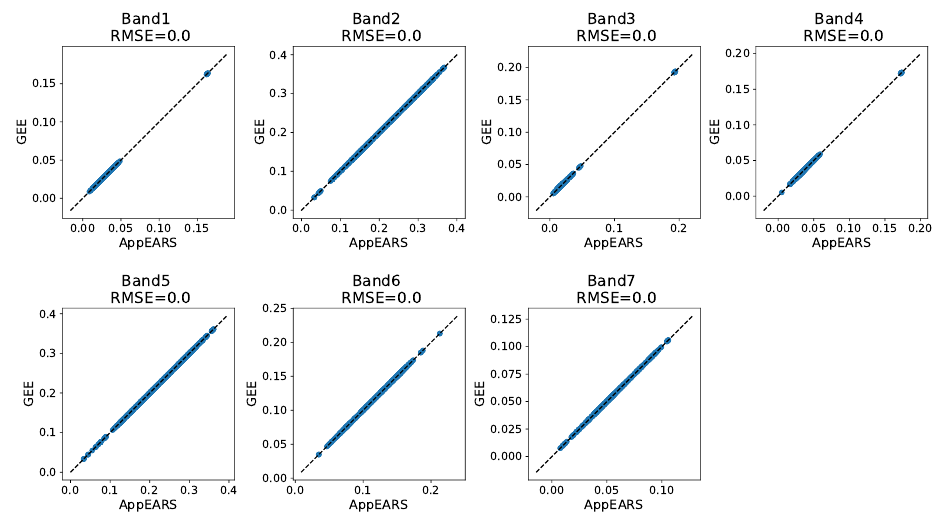
Figure A1. MCD43A4-006 [64] single-pixel reflectance time-series from GEE ( y -axis [65]) and Ap- pEARS ( x -axis [66]) datasets. The nearest pixel to Speulderbos forest site (NL-Spe, 52.251185 ◦ N, 5.690051 ◦ E) for the period from 1 January 2016 to 1 October 2020 (1736 products).